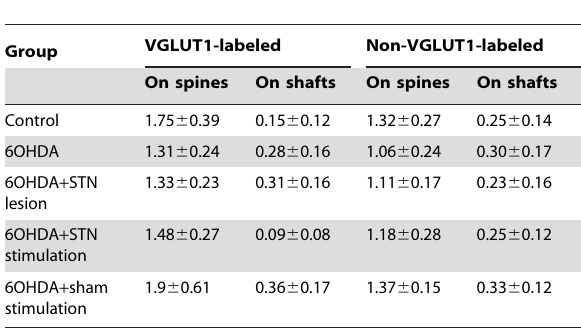
Table 1. Mean numbers of VGLUT1-labeled or –unlabeled synapses on spines and shafts per field of view (32 m m 2 ) 6 standard deviation. Differences were not statistically